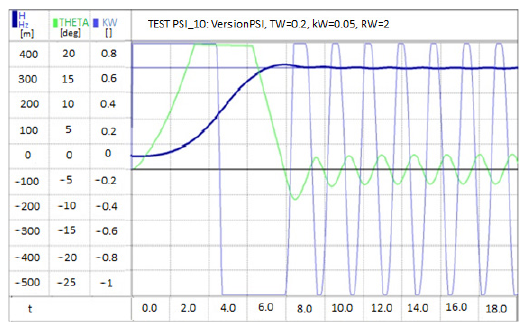
Figure 3. The transitional process of controlling flight altitude ( H ) depending upon the value of the coefficient of control ( k w = 0.05), by making step changes to the given value from 50 metres to 400 metres, for the derivative constant of R w = 2 [s]